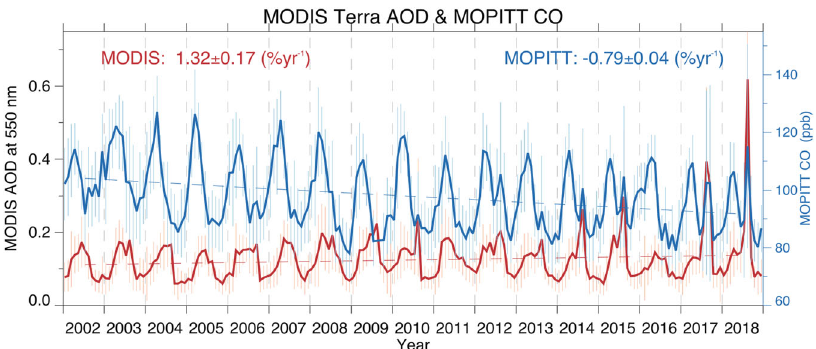
Fig. 2 Paci fi c Northwest time series and trend analysis of atmospheric composition from 2002 to 2018. We show Measurements of Pollution in the Troposphere (MOPITT) monthly average carbon monoxide (CO) as units of column average volume mixing ratio in parts per billion (ppb, blue) and Moderate Resolution Imaging Spectroradiometer (MODIS) monthly average aerosol optical depth (AOD, red). Error bars represent monthly standard deviation. Vertical gray dashed lines indicate the beginning of each year. Trends are determined using the weighted least squares estimate of the slope from data anomalies, and include the standard error of the slope estimate. For CO the mean sample size, n , is 1110 observations; for AOD the mean sample size, n , is 240 observations. Full details of all n values are provided in the Source Data fi le.